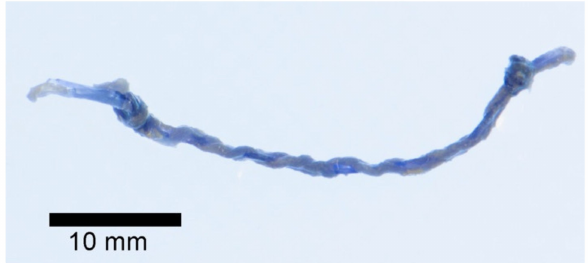
Figure 8. BraidStent-SF sample in T2. It can be appreciated that the SF coating has practically